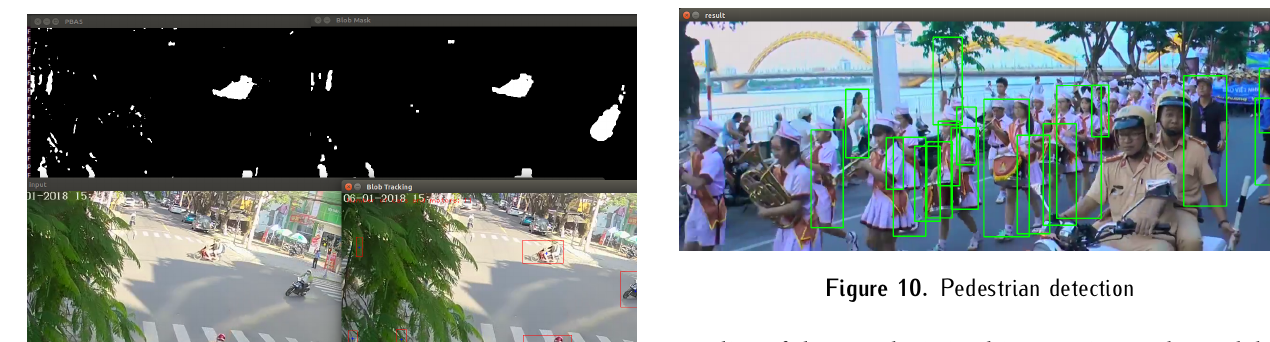
Figure 9. Pedestrian detection process